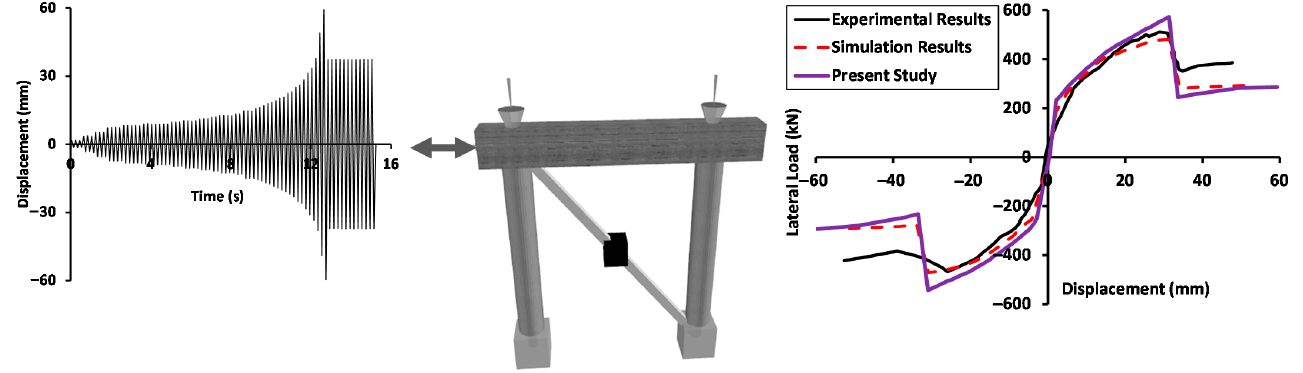
Figure 8. Comparison of inelastic analysis results and previous experimental and analytical studies of bridge bent retrofitted with BRB2: cyclic loading protocol used in the multi-column bridge bent inelastic analysis ( left ) and backbone curves ( right ).